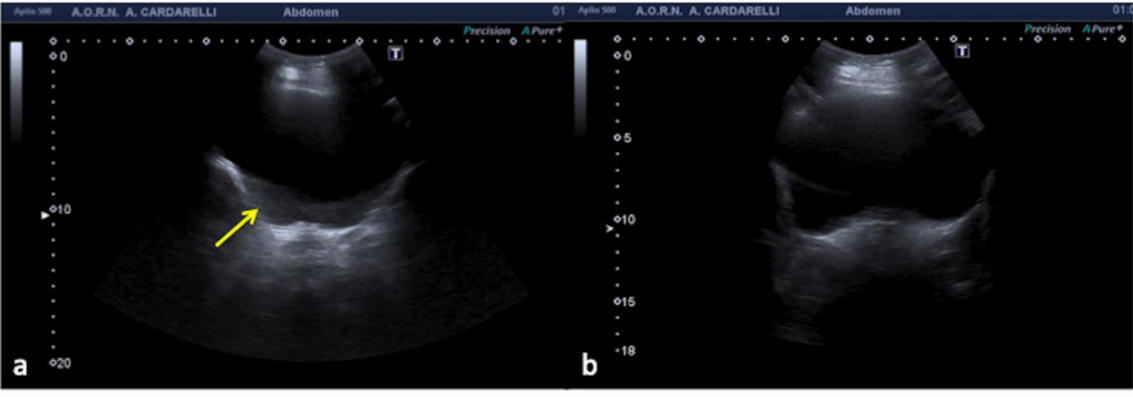
Figure 2. Transverse US image of filled bladder shows echoes ( a , arrow) in the expected anechoic urine. Transverse US image obtained after optimal placement of the transducer ( b ) shows resolution of the intra-bladder echoes.